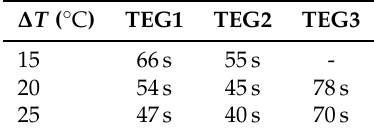
Figure 11. Simulated dependencies of the load voltage ( V L ) and load power ( P L ) vs. time for three TEGs at ∆ T : ( a ) 15 ◦ C; ( b ) 20 ◦ C; ( c ) 25 ◦ C. Table 6. Cold boot times of WSN nodes with considered TEGs for different ∆ T